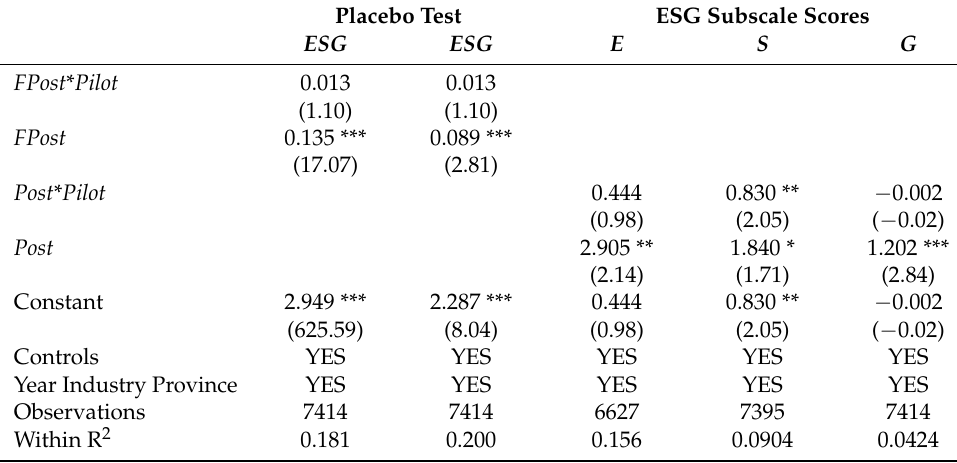
Table 8. Robustness check: Placebo test and ESG subscale scores.